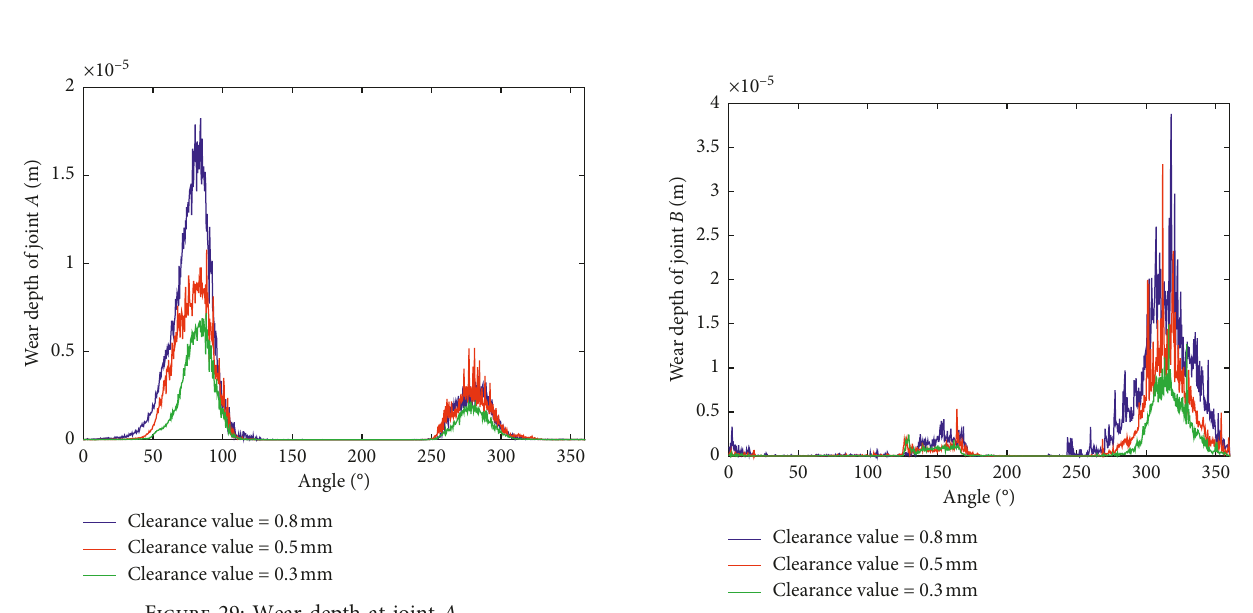
Figure 30: Wear depth at joint B